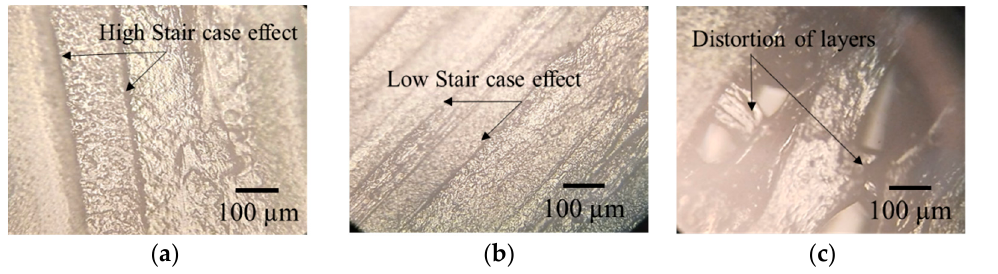
Figure 15. Optical microscope images ( a ) high staircase effect at 0.3 mm layer height, ( b ) high staircase effect at 0.1 mm layer height, ( c ) distortion of layers due to thermal stresses at 0.3 mm layer height and 50% infill density.